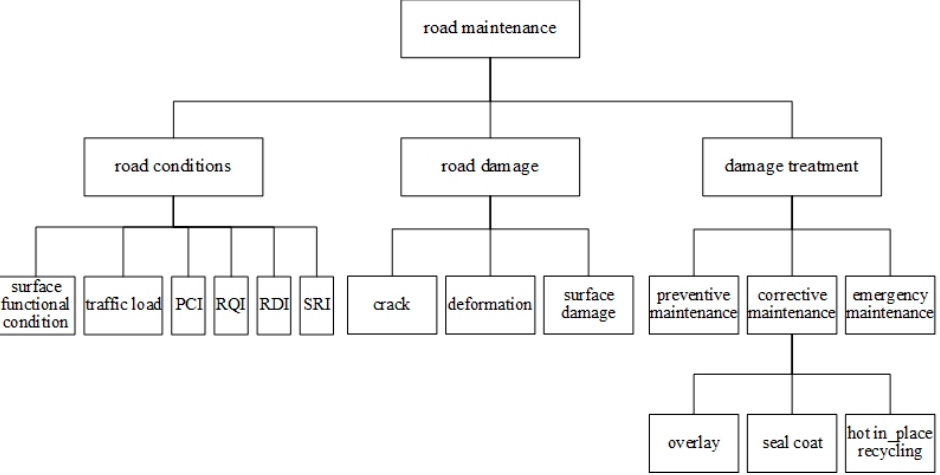
Figure 3. The basic conceptual structure of road renewal.